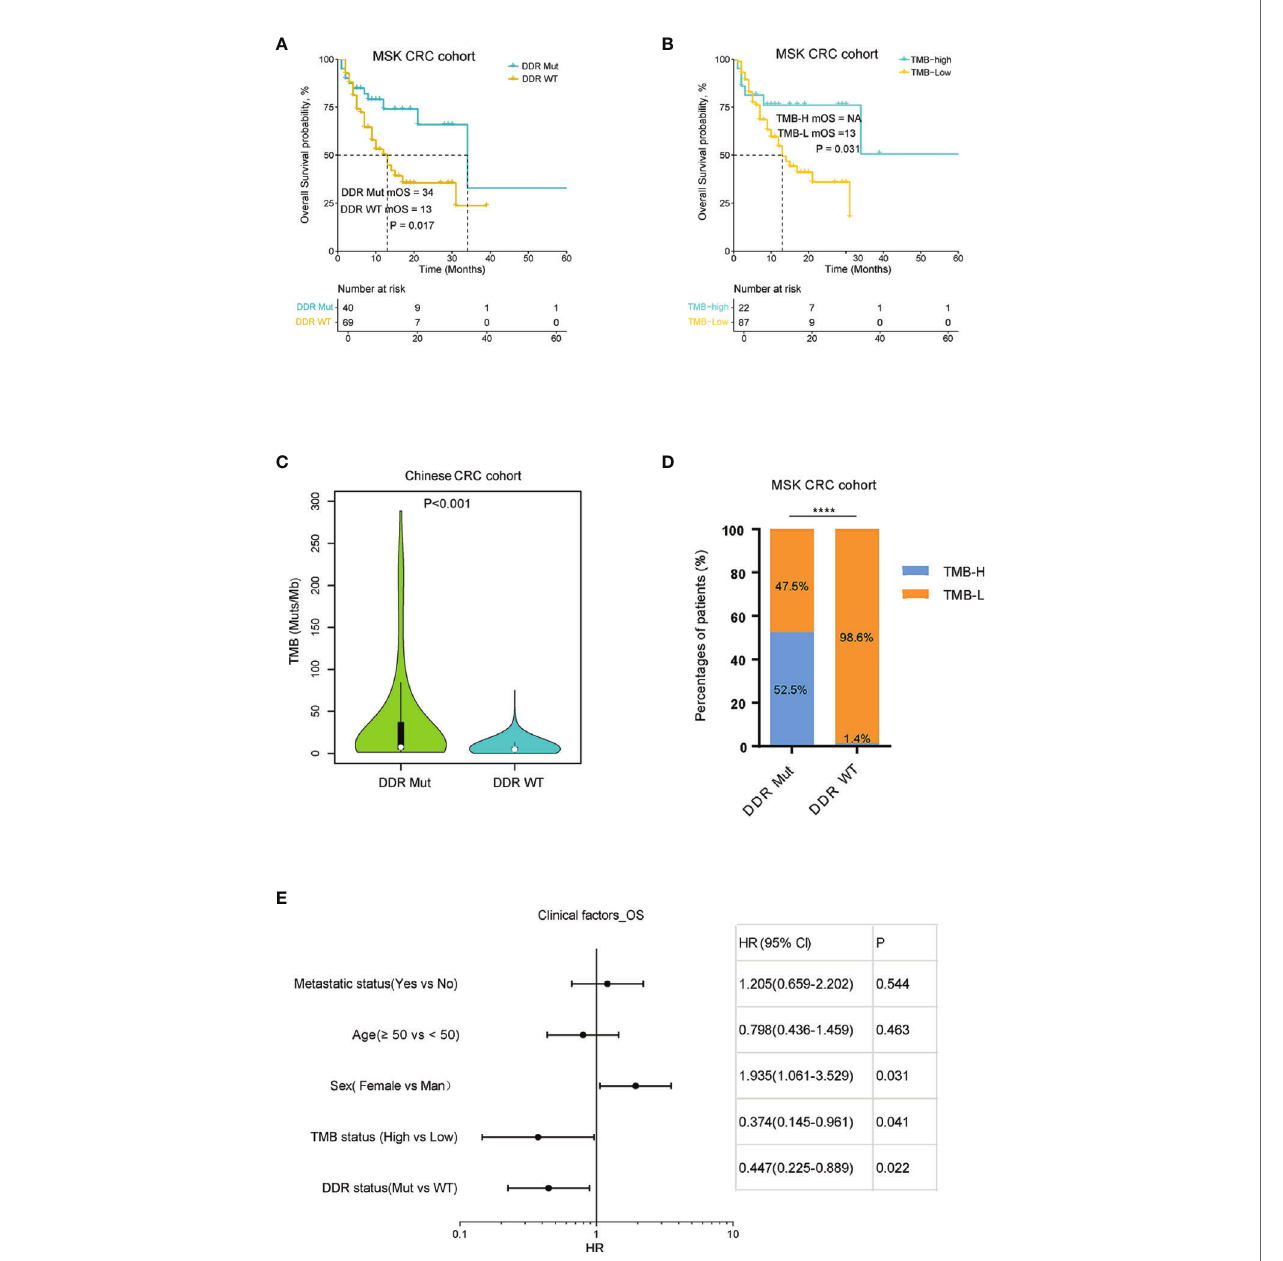
FIGURE 2 | DNA damage repair (DDR) mutation and tumor mutational burden (TMB) correlated with the prognosis of colorectal cancer (CRC) patients with immune checkpoint inhibitor (ICI) immunotherapy. (A) Kaplan-Meier curves of overall survival for DDR Mut and WT groups. (B) Kaplan-Meier curves of overall survival for TMB-High and TMB-Low groups. (C) Distribution of TMB in DDR Mut and WT groups. (D) The proportion of TMB-High and TMB-Low in DDR Mut and WT groups. (E) Univariate Cox regression analysis of overall survival (Cox proportional hazards regression model). ****P <